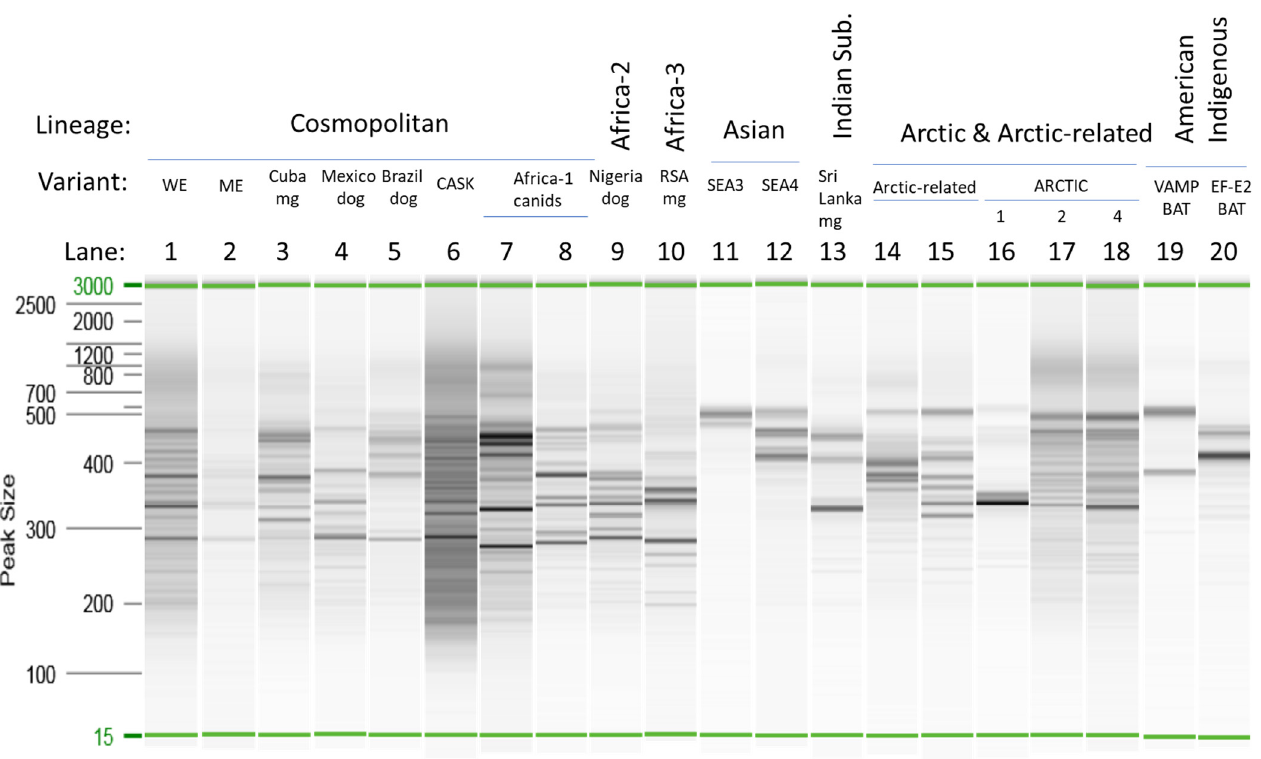
Figure 2. Amplicon profiles of sample aliquots from the cleaned Ampliseq for Illumina library as analyzed by a QIAxcel system. A 15–3000 bp reference marker was included in each run. Lanes 1–20 represent the unfixed samples as follows: 1, V285; 2, V661; 3, V1061; 4. V682; 5, V904; 6, V648; 7, V671; 8, V1453; 9, V463; 10, V050; 11, V1145; 12, V1375; 13, V114; 14, V704; 15, V737; 16, 01RABN00053; 17, V809; 18, V804; 19, V982; and 20, 72RABL03675. Variants were identified as indicated in Table S1. Abbreviations: mg, mongoose; Indian Sub., Indian Subcontinent; RSA, Republic of South Africa.